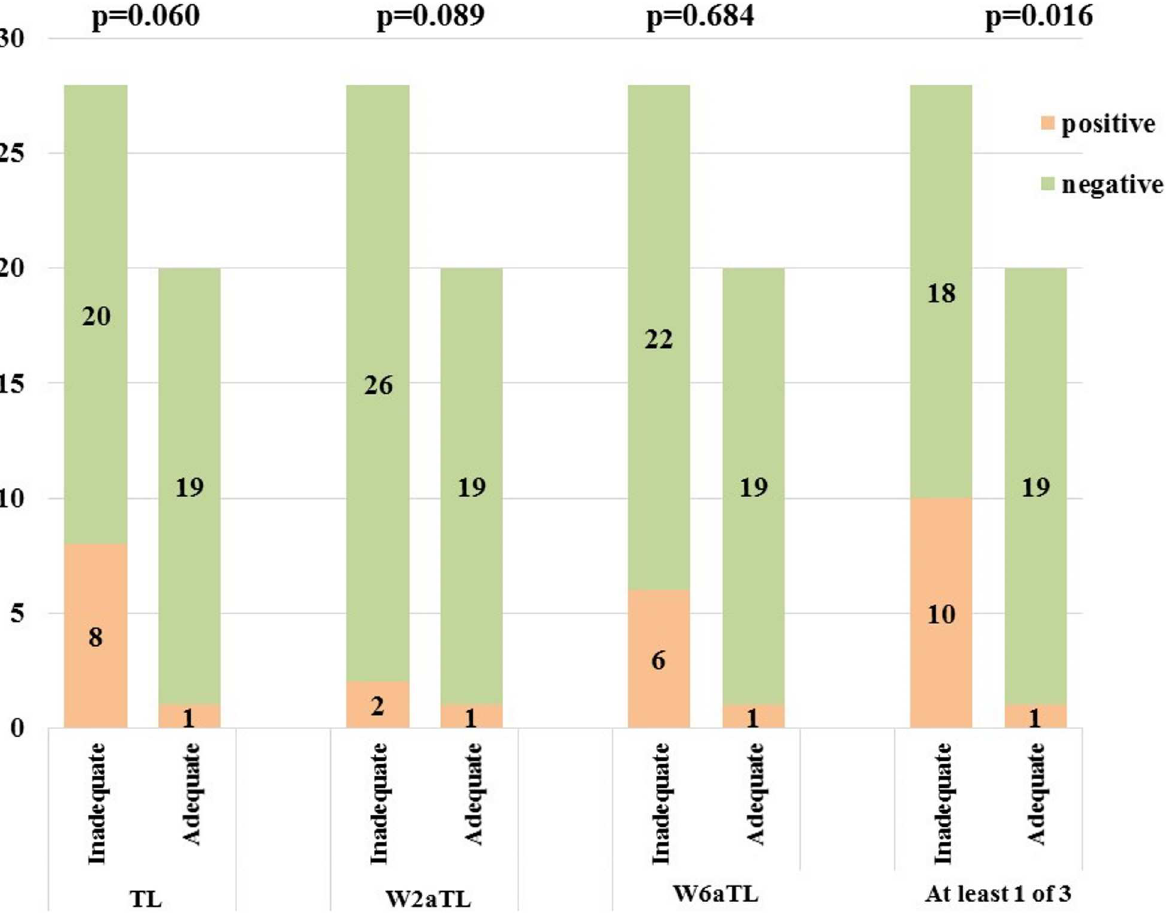
Fig 4. Proportion of ATI positivity in the adequate and inadequate responder